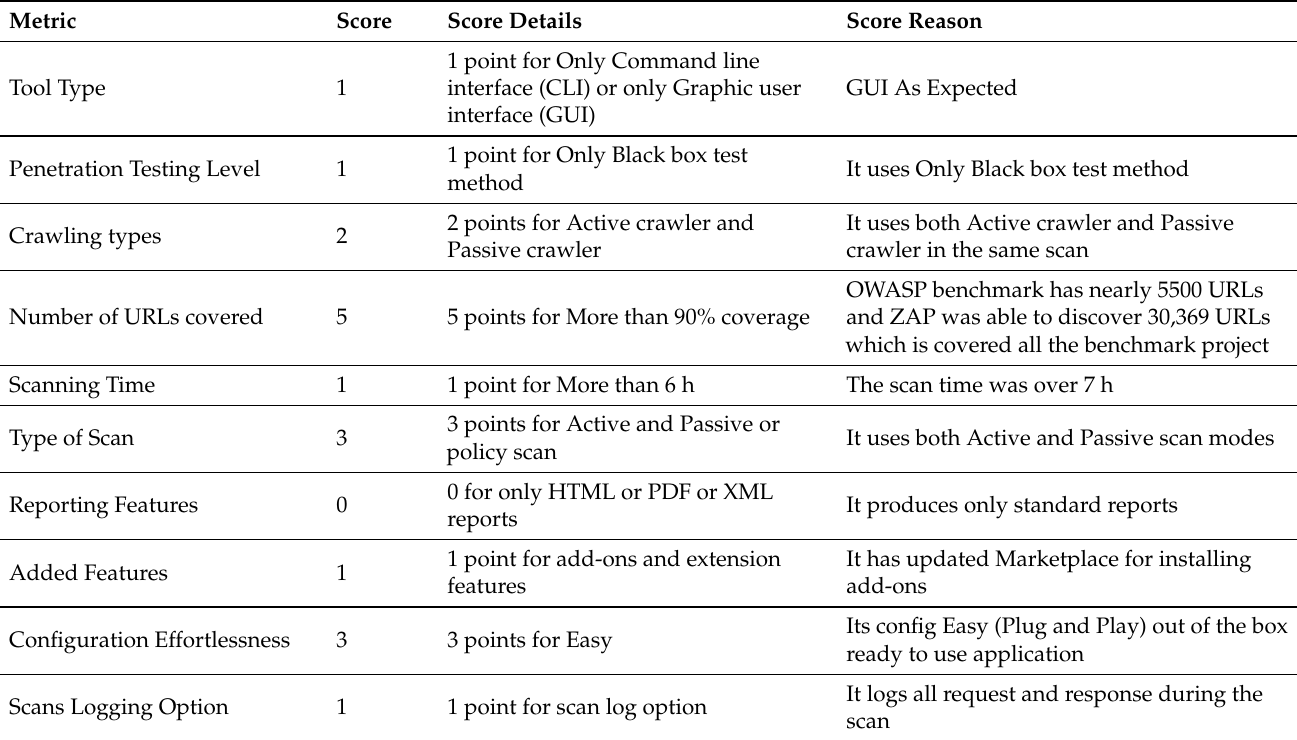
Table A1. Results of benchmarking OWASP ZAP using our proposed framework in